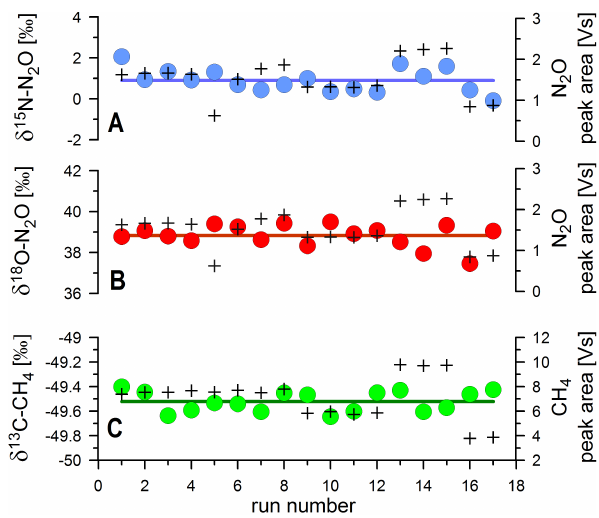
Fig. 7. Results of QCS measurements. The circles of the per- formance chart display the isotope ratio measurements of δ 15 N- N 2 O (A) , δ 18 O-N 2 O (B) and δ 13 C-CH 4 (C) as determined during the QCS measurements by injecting variable amounts of AL. The crosses relate to the y axis on the right-hand side and indicate the IRMS peak area of the respective measurement. The lines show the average δ values of the